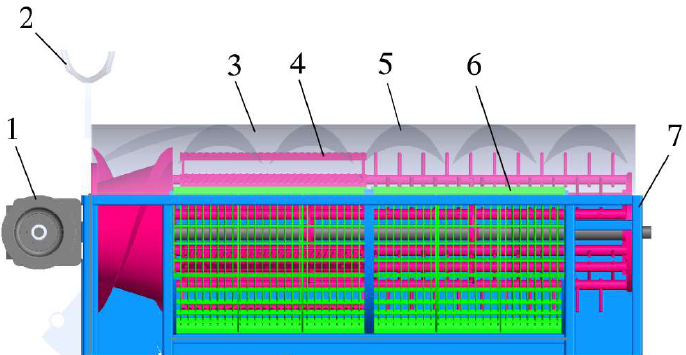
Figure 4. Switching diagram of a combination of decide granular device structure: (1) Enter the gearbox of the drum power in the drum. (2) Removing the barrel with the barrel. (3) Persia roller lid. (4) Combined moldy granular drum. (5) Grass guide. (6) Narrow grille concave board. (7) Welding in a departure drum.